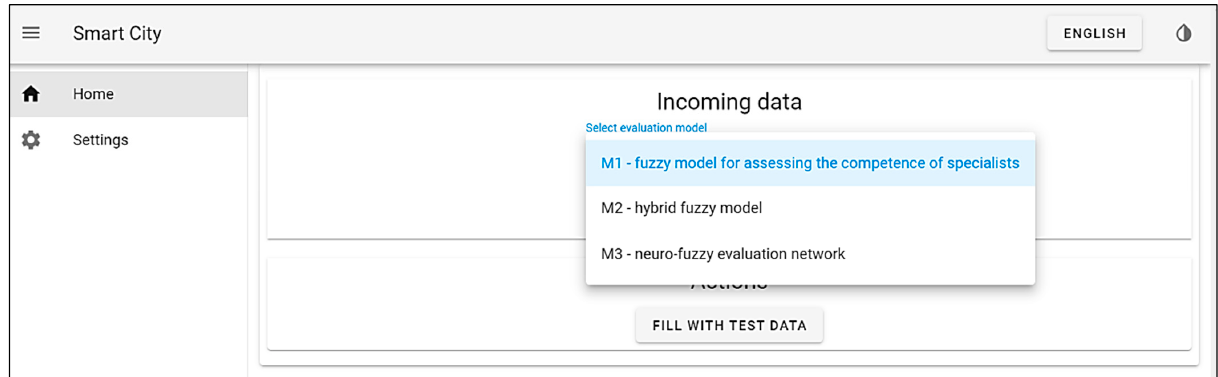
Figure 5. Values of neuronal excitation level ( (cid:1852) (cid:2869) ; (cid:1852) (cid:2870) ; (cid:1852) (cid:2871) ) and postsynaptic potential function ( (cid:1849) (cid:2869) ; (cid:1849) (cid:2870) ; (cid:1849) (cid:2871) ).